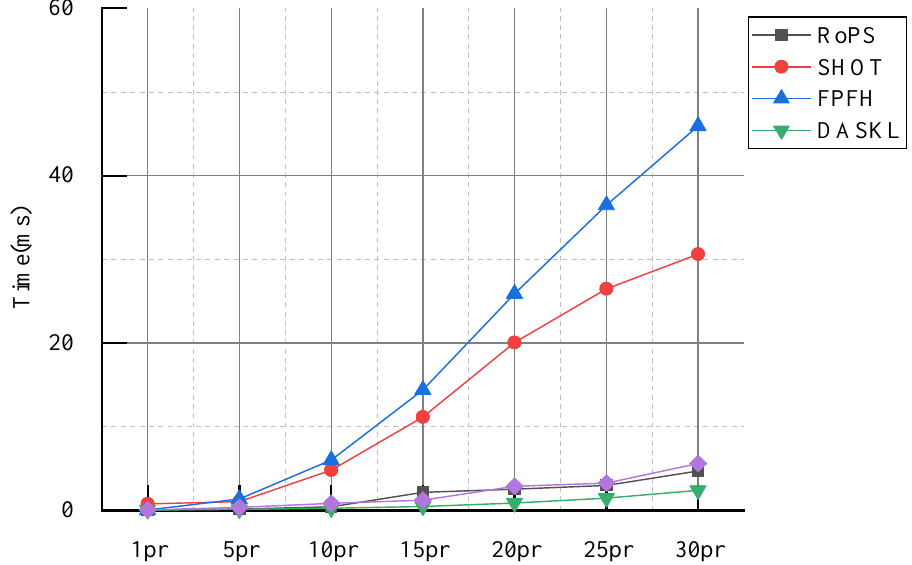
Figure 12. Comparison of feature generation time of different features.